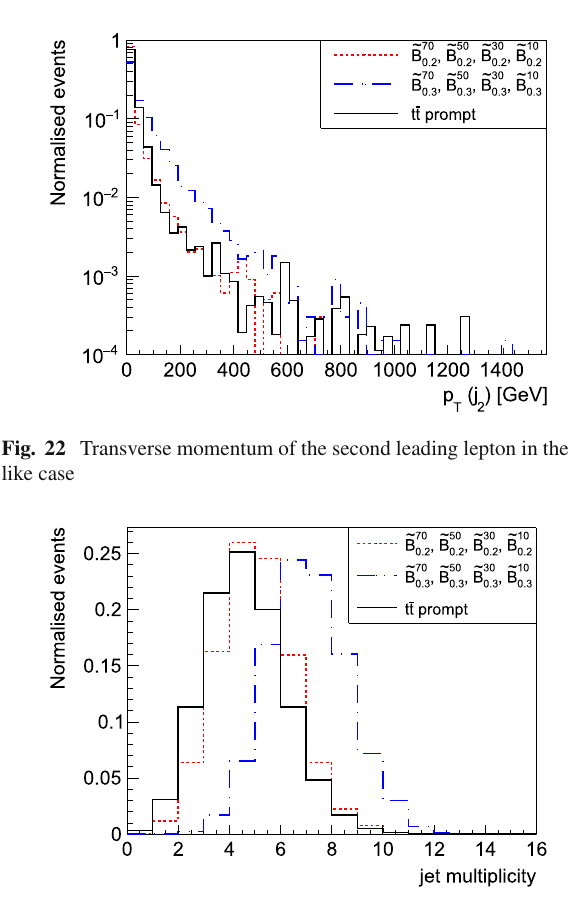
Fig. 23 Jet multiplicity N J in the ˜ B -like case